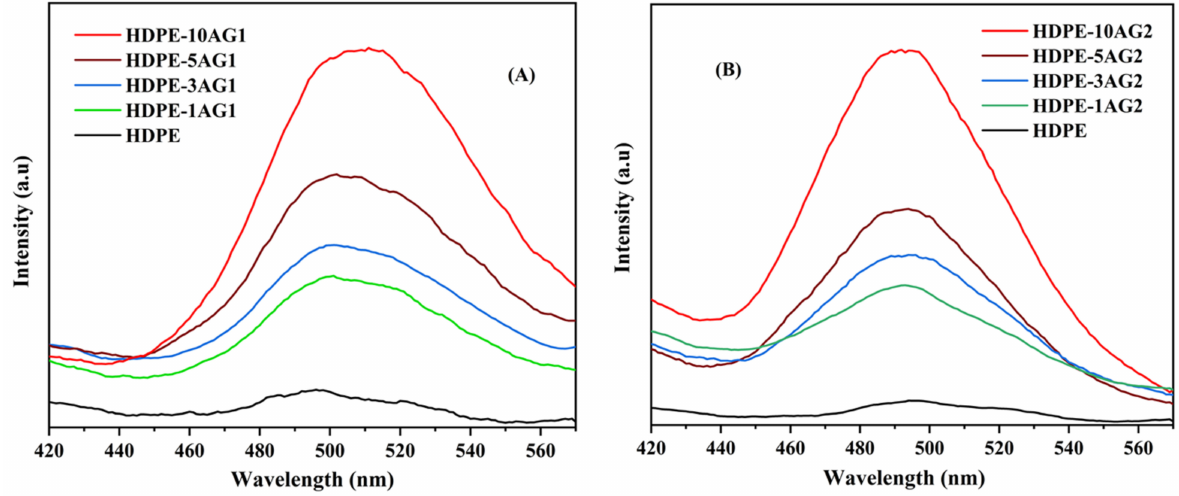
Figure 6. Phosphorescence emission in HDPE, HDPE/AG 1 ( A ), and HDPE/AG 2 ( B ) composites. The HDPE/AG 1 (green) and HDPE/AG 2 (blue) emission under darkness can be visible from Figure 7, and the intensity of emission is proportional to the filler content (AG 1 and AG 2 : 1 to 10 wt.%).